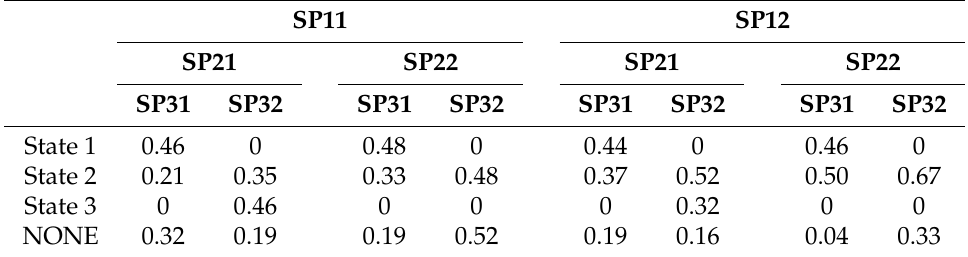
Table 4. Example of the final CPT for the first approach, using the ‘NONE’ state for all combinations of parent states that are not possible.